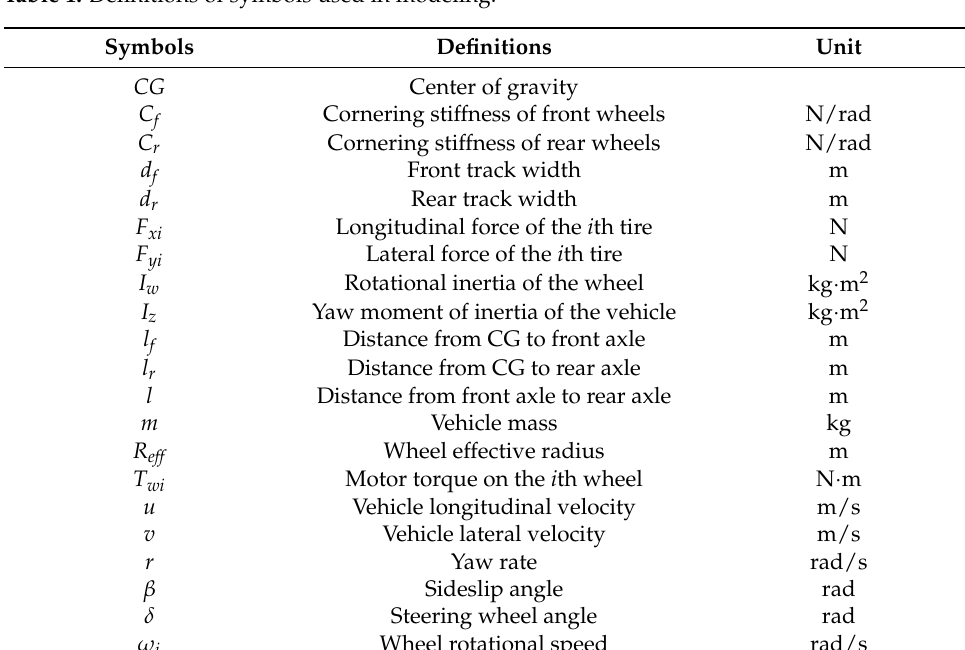
Figure 1. Vehicle plane motion model. Table 1. Definitions of symbols used in modeling.